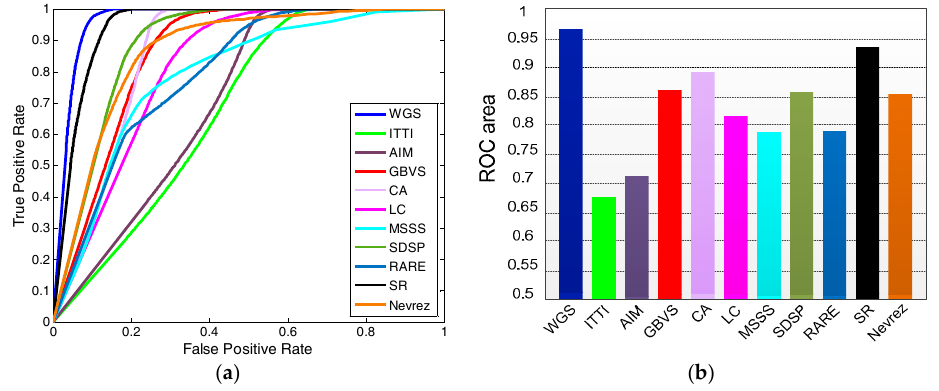
Figure 14. The ROC curves and the AUC values of different saliency models:( a ) ROC curves; and ( b ) AUC. If the curve is closer to the upper left corner, the performance of the saliency model is